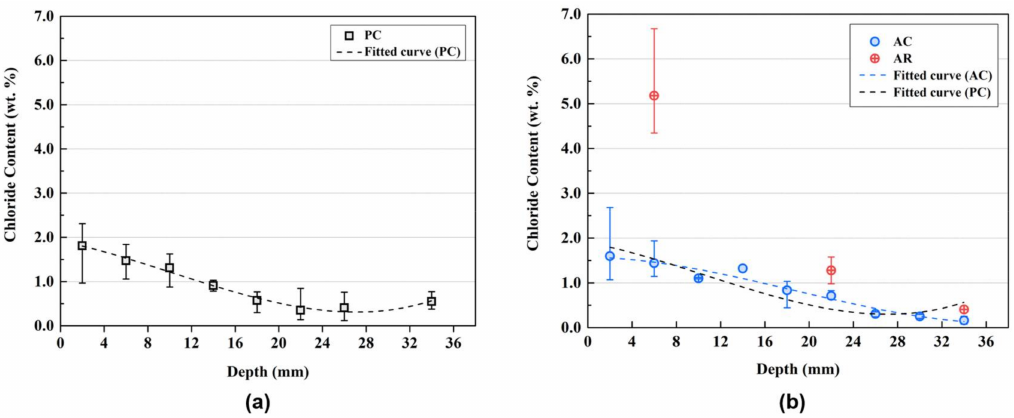
Figure 6. Chloride profile of the mortar specimens: ( a ) chloride content of PC; and ( b ) chloride content of AC.